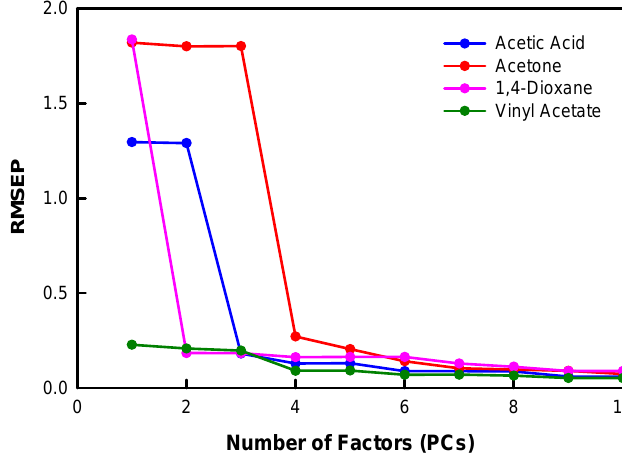
Figure 7. RMSEP versus number of factors (PCs) for each analyte of interest in the PLS2